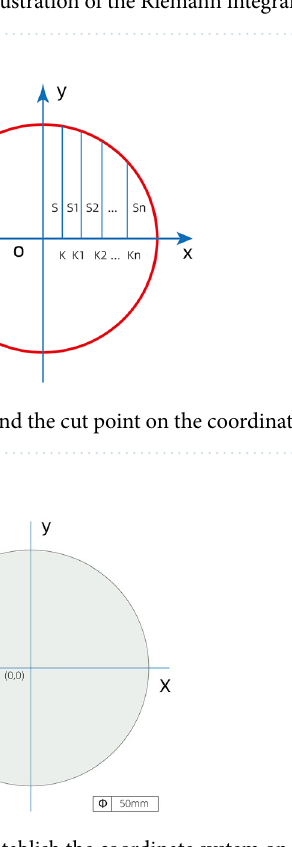
Figure 4. Establish the coordinate system on a circle with a diameter of 50